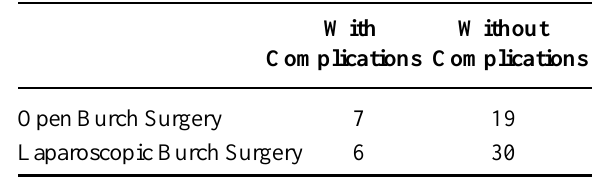
Table 6 – Presence of complications until the 7th postop- erative day ( c 2 = 17.48, p < 0.001).